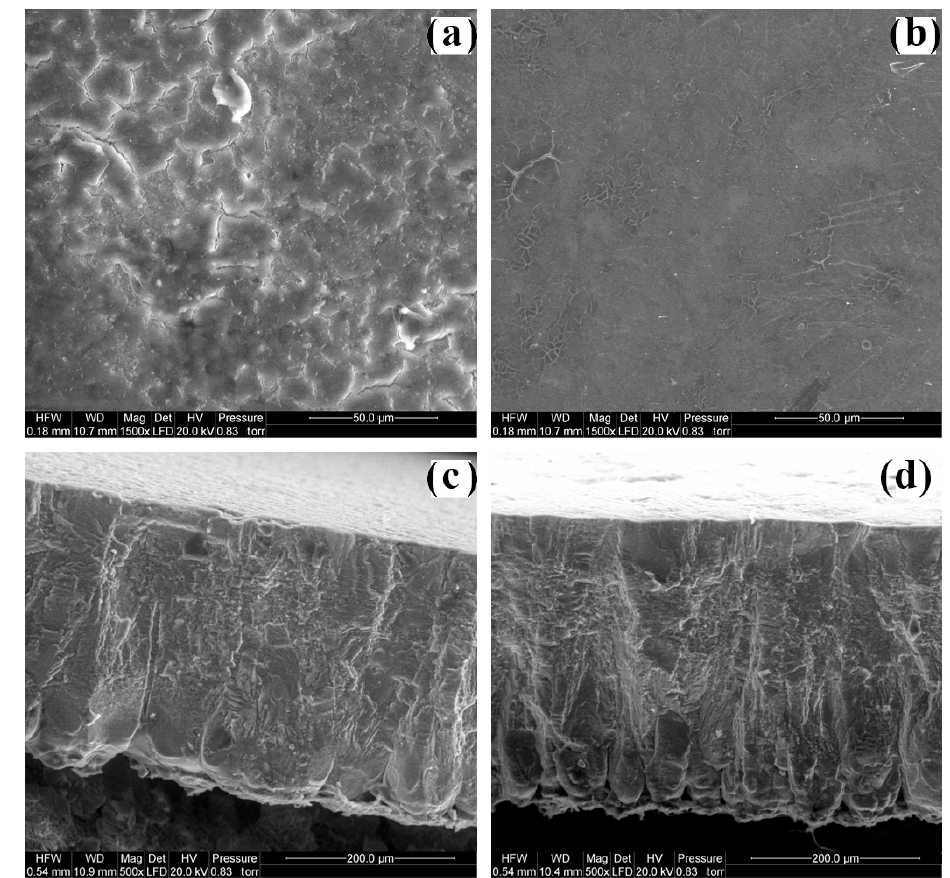
Figure 2. Scanning electron microscopy (SEM) images of the surface and a cross section of egg shells in the control group (a, c) and the experimental group (b, d) , respectively.